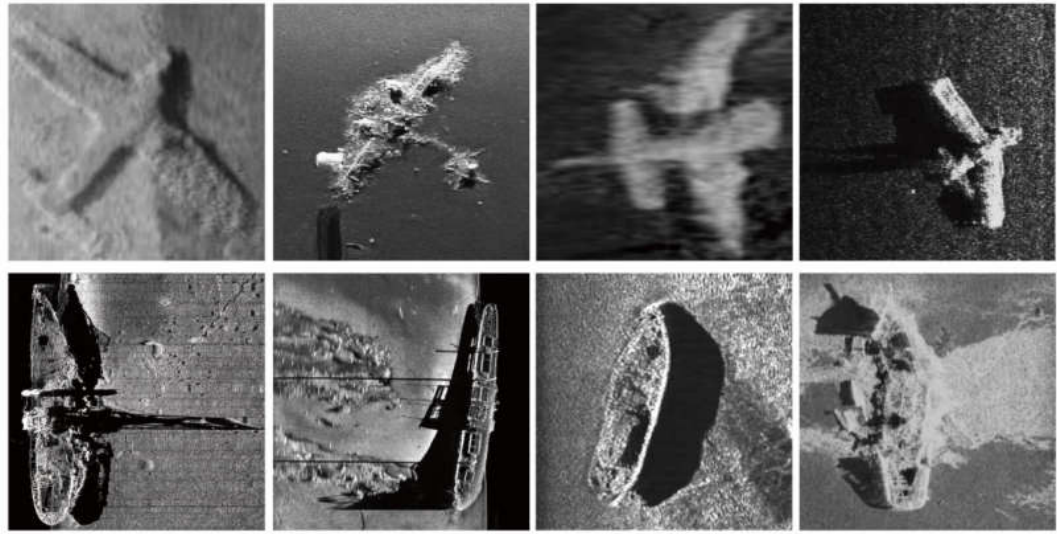
Figure 4. Samples from the SeabedObjects-KLSG dataset. Samples in the first and second rows are planes and ships, respectively.